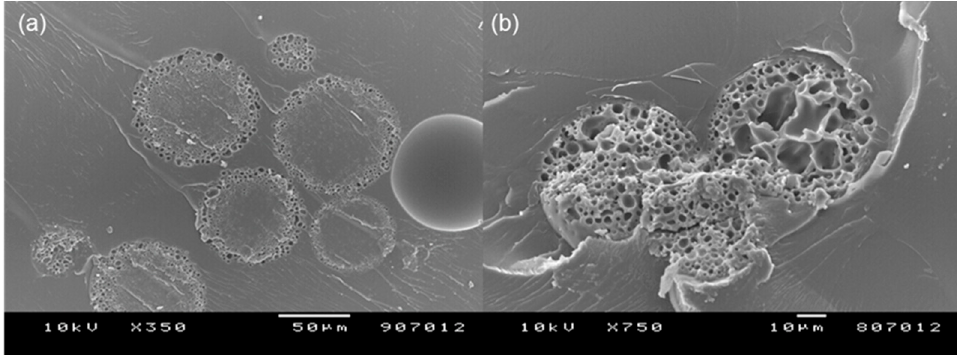
Figure 10. SEM images of the internal morphology of closed-pore PLGA microspheres prepared using 7 mL of the ammonia solution. Dried microspheres were first equilibrated in an aqueous solution containing 0.2% either ( a ) Tween 80 or ( b ) CTAB, and were then subjected to self-healing.